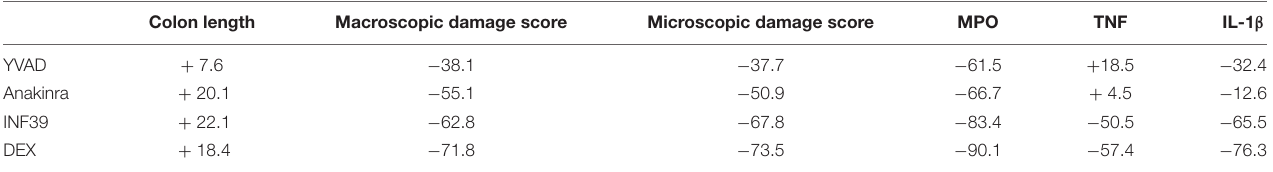
TABLE 1 | Synoptic presentation of percent changes of tissue-related inflammatory parameters in DNBS-rats treated with YVAD, anakinra, INF39 or DEX against values estimated in animals with colitis. Colon